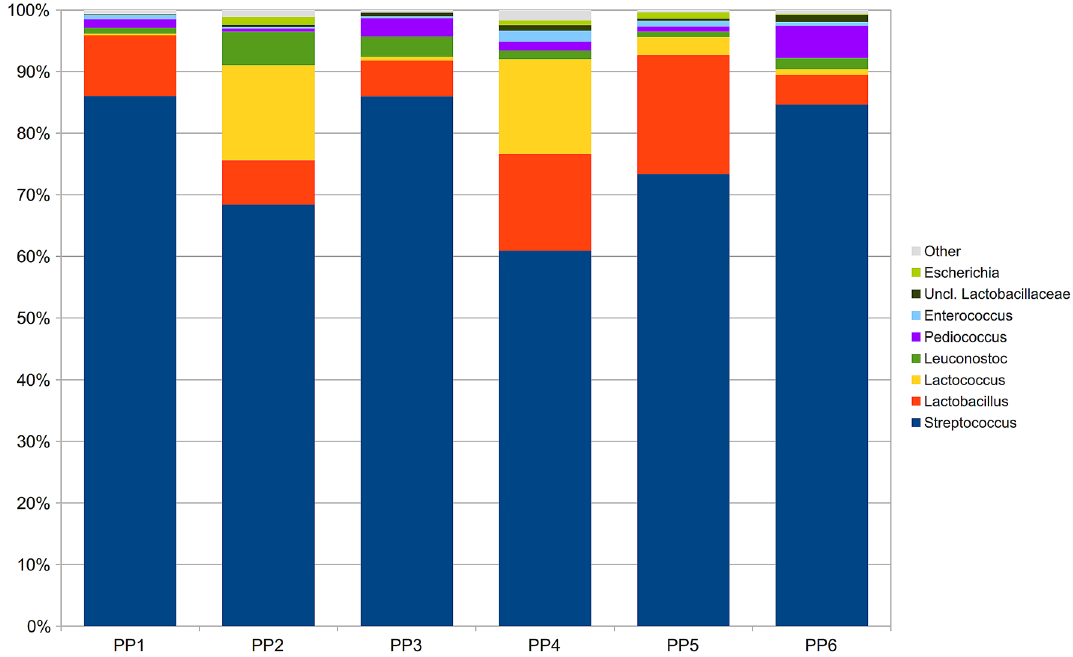
Figure 2. Stacked barplots depicting the average microbiota composition of HR cheese samples at genus level per each Pasture area-Producer. Data is presented as relative abundance on the overall microbial composition. Genera below 0.5% rel.ab. on average were grouped in “Other” category.